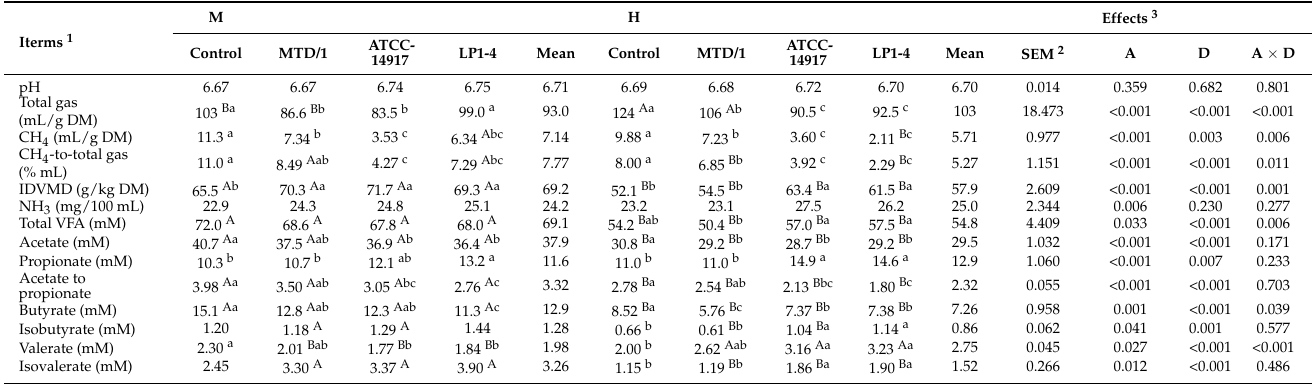
Table 1. In vitro ruminal fermentation characteristics of silage inoculated with bacterial